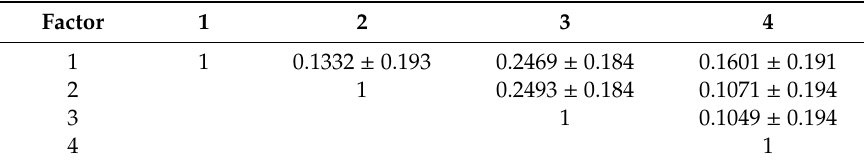
Table 3. Correlations between factor scores with 98% confidence interval [32] (p. 286).